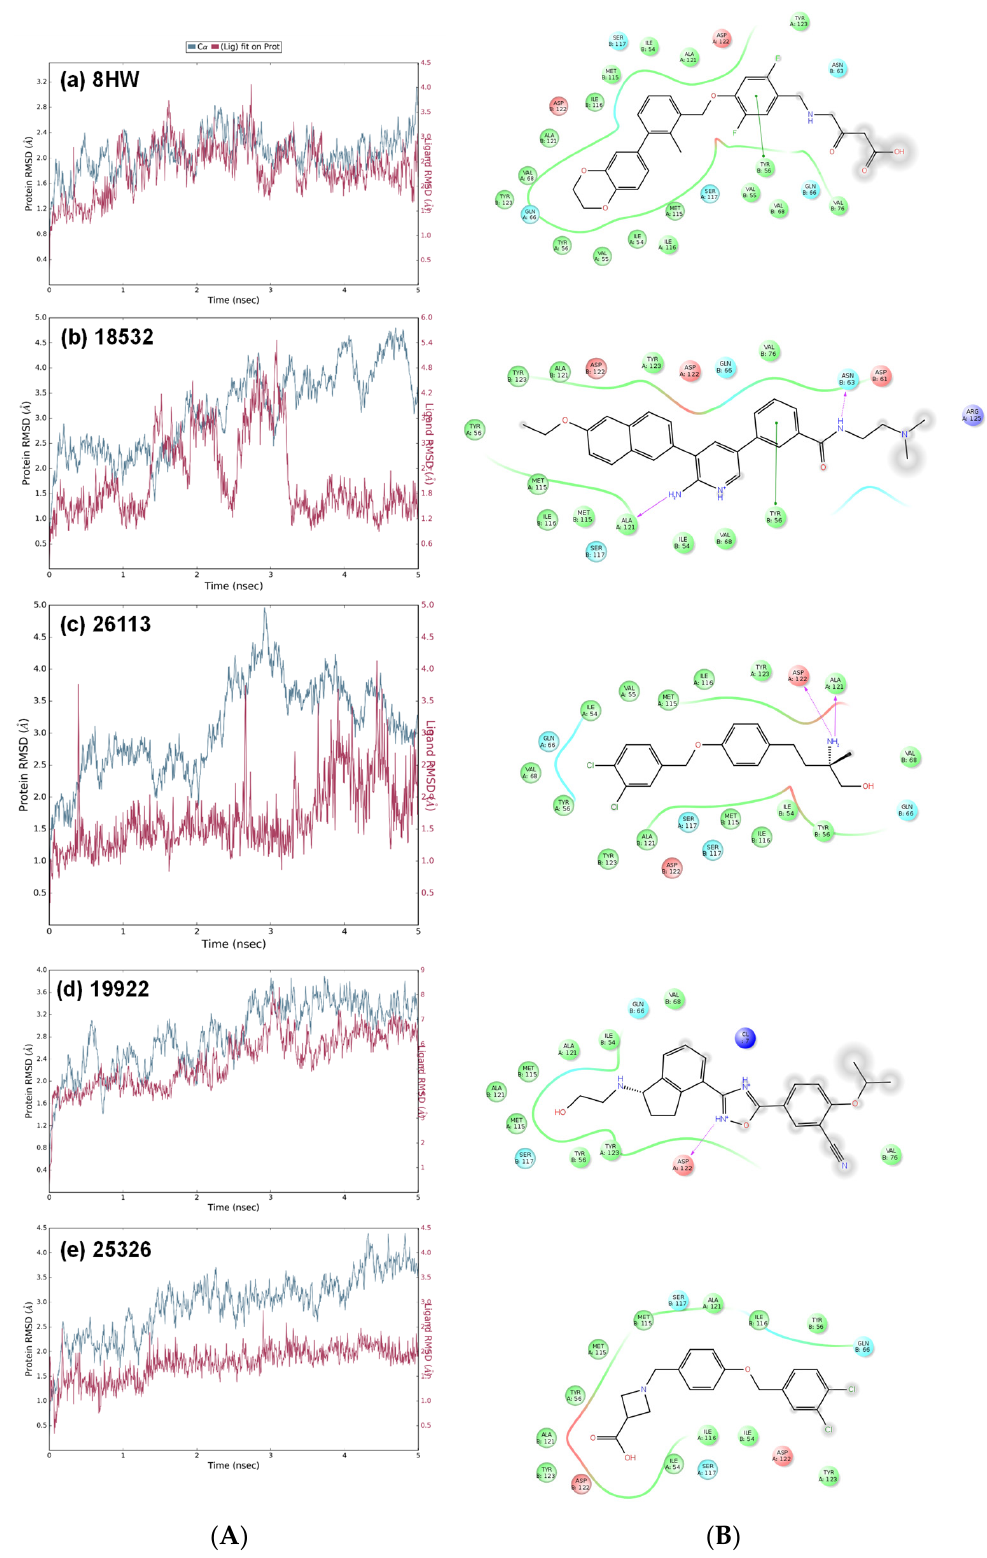
Figure 4. The MD simulation data for crystal ligand (8HW), three hits (18532, 26113, and 19922), and a structural analog (25236): ( A ) The RMSD analyses over 5000 ps molecular dynamics simulation of ligand binding in the PDL1 dimer pocket; and ( B ) the ligand–protein interaction diagram at the end of MD simulation.